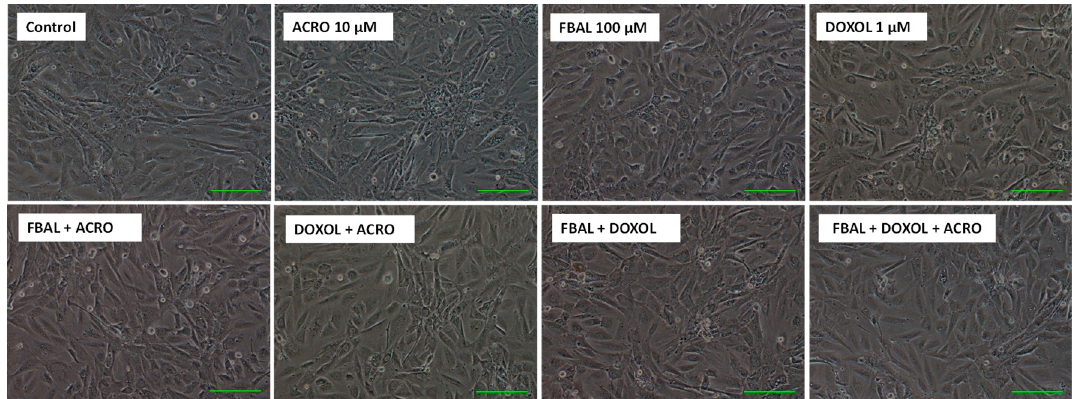
Figure 8. Phase contrast microscopy of differentiated H9c2 cells after a 48 h exposure to metabolites (FBAL 100 μ M, DOXOL 1 μ M, ACRO 10 μ M) or in combination. Images are representative of two independent experiments. Scale bar: 100 μ M.